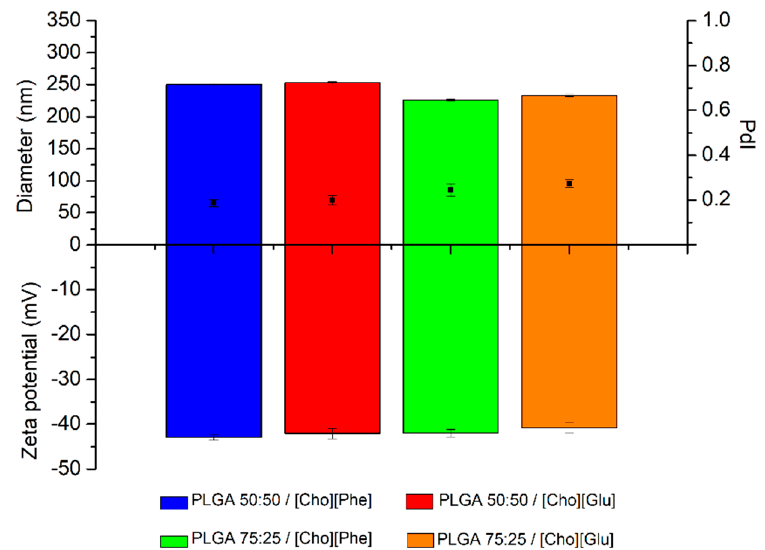
Figure 1. Diameter (nm) (top bars), PdI (black squares), and zeta potential (mV) (bottom bars) of IL-polymer nanoparticle hybrid systems ( n = 3, mean ± SD).